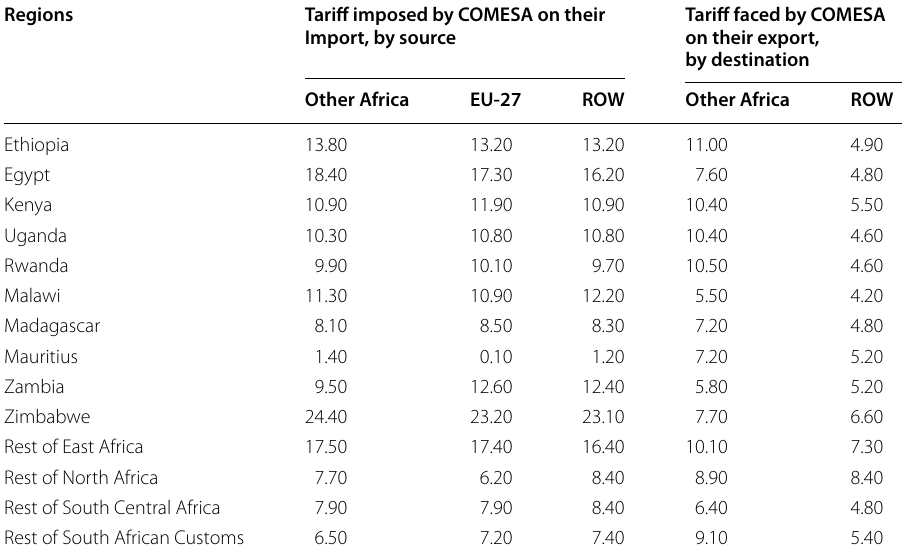
Table 2 Tariff protection structure for COMESA (Percentage). Source: GTAP 9 database Regions Tariff imposed by COMESA on their Tariff faced by COMESA Import, by source on their